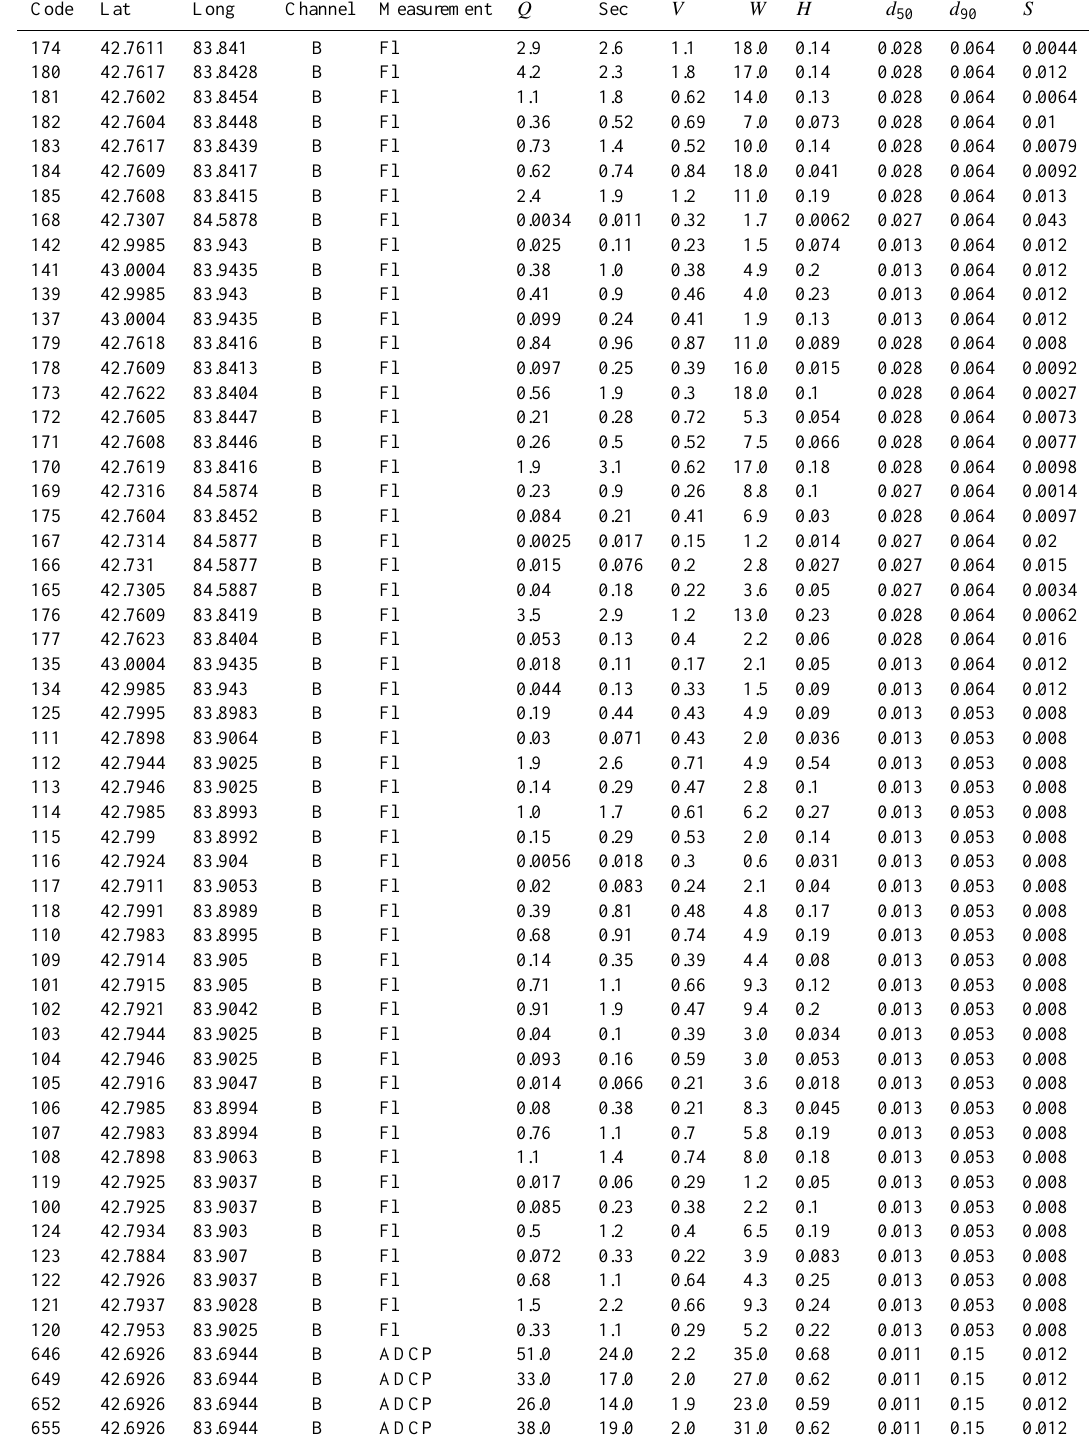
Table 1. Data gathered for braided-river threads. Latitude (lat) and longitude (long) are in degrees centesimal; measurement stands for measurement type (Fl: float, ADCP: acoustic Doppler current profiler); Q : discharge, Sec: wetted area, V : average velocity, W : width, H : depth, d 50 : median grain size, d 90 : size of the 90th percentile, S : slope. All physical quantities are given in the International System of